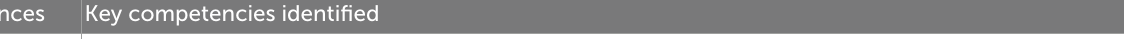
TABLE 2 A chronological summary of E.D. 4.0 competencies as identified by some prior researchers.